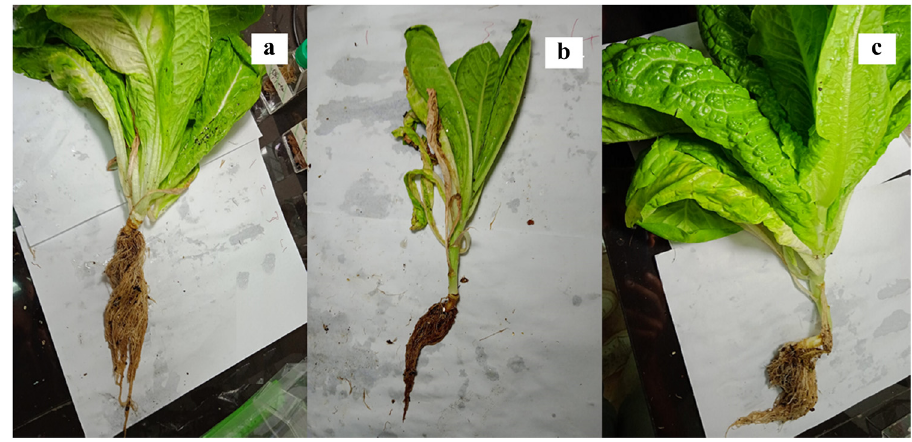
Figure 2: Comparison of lettuce plants ’ vegetative and root growth post - arti fi cially infested with Meloidogyne spp. Lettuce trapped with ( a ) sorghum ( S. bicolor ) , ( b ) mustard ( B. juncea ) , and ( c ) control.